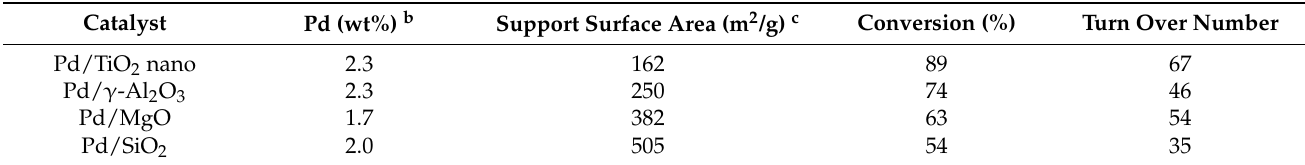
Table 1. Physico-chemical properties of metal oxides-supported Pd catalysts and their catalytic performance in tars-type compounds mild hydrotreatment a .